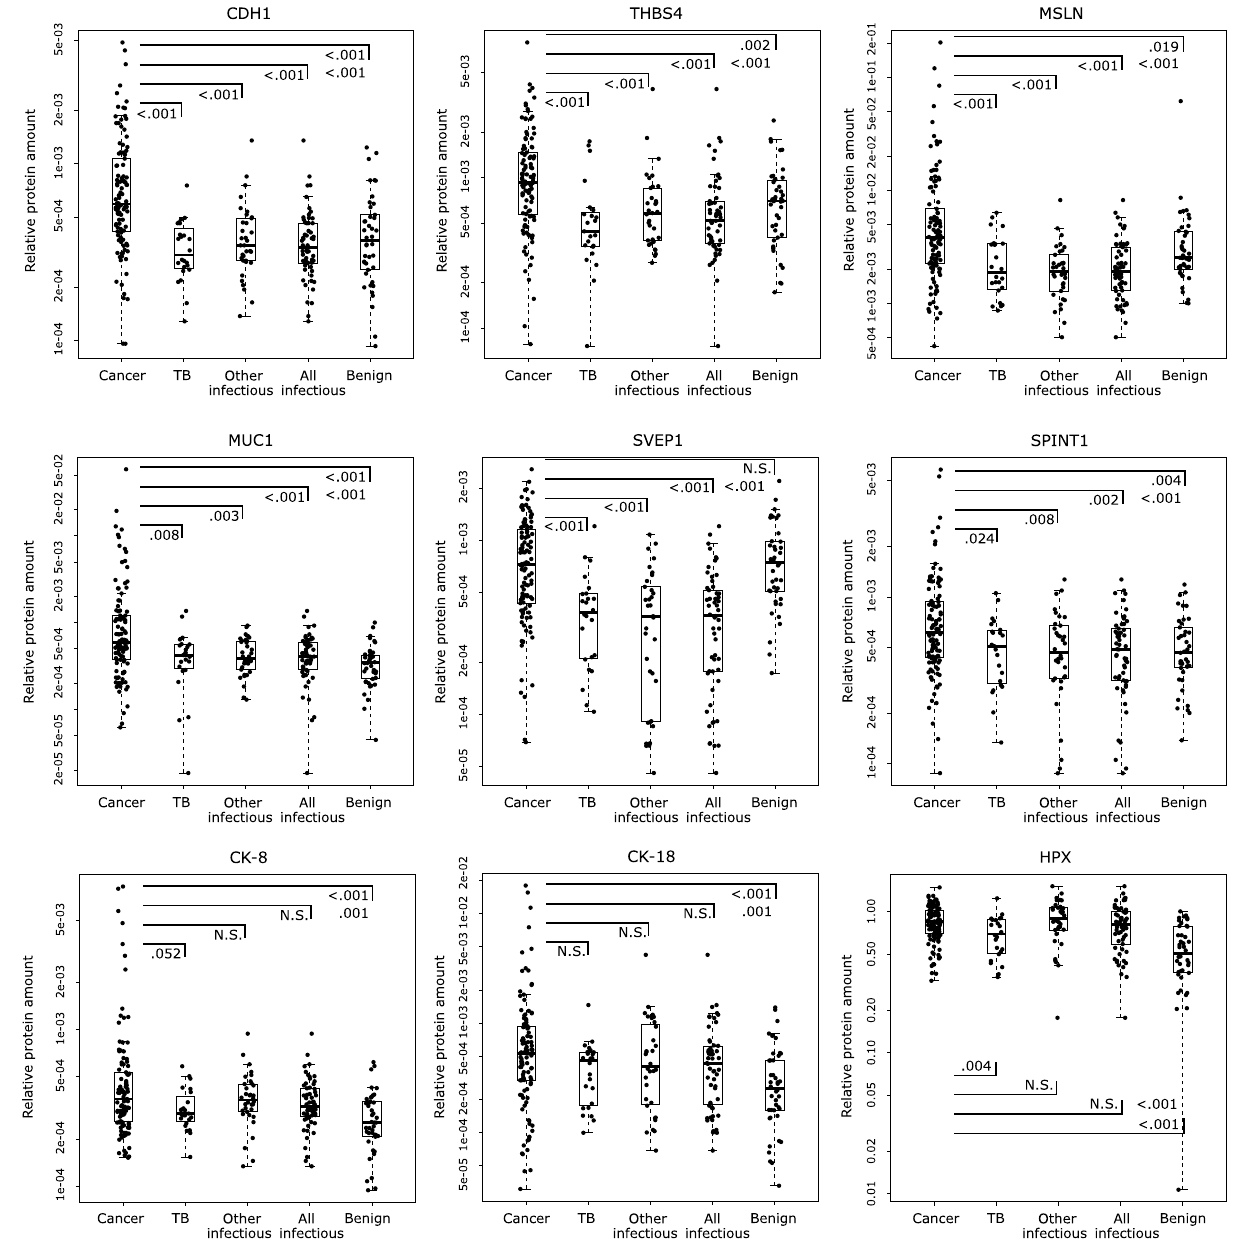
Figure 1. Proteins significantly elevated in the cancerous-PEs. Relative protein amounts in 209 patient PEs. Statistical significance (Mann–Whitney U test p-value) is indicated for the comparison of the cancerous-PEs vs. the TB-PEs, other-infectious-PEs, all-infectious PEs (TB-PEs and other-infectious-PEs combined), or benign- PEs (black lines), and vs. all other PEs combined (p-value between the all-infectious and benign PEs). Other MWU test results can be found in Table 2. Box-plots indicate the median and quartiles, with whiskers indicating the 1.5 interquartile